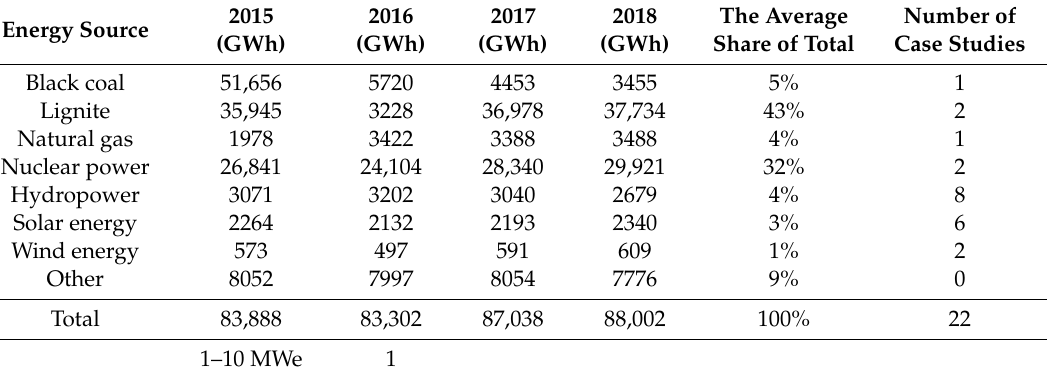
Table 1. Overview of electricity production in the Czech Republic in the period 2015–2018 based on the energy sources and technologies considered in the presented study